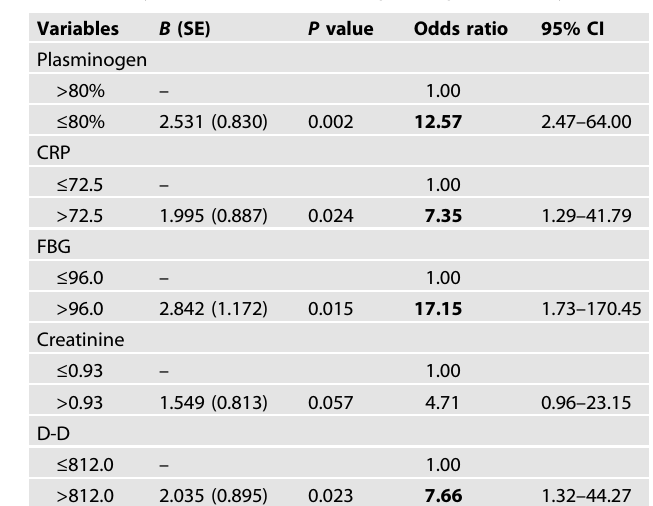
Table 2. Risk of death in COVID-19 patients by level of selected in fl ammatory parameters (univariate logistic regression analysis).